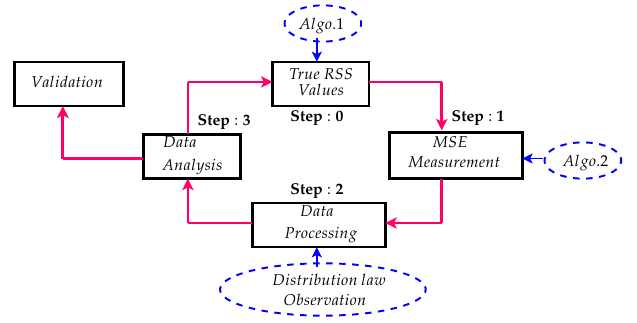
Figure2. The basicmodel of